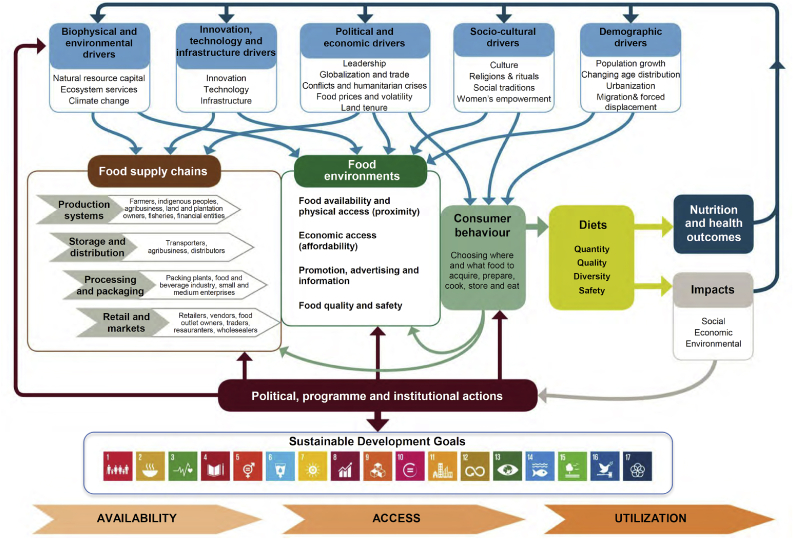
Conceptual framework of food systems for diets and nutrition. Source: HLPE (2017).